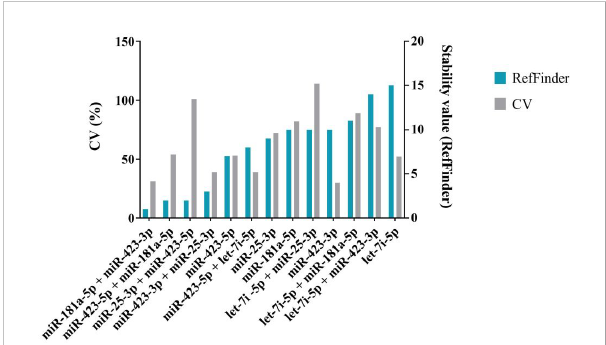
FIGURE 4 Analysis of a selection of endogenous controls and their combinations. The coef fi cient of variation (%) is shown in grey on the left y-axis. The stability values of the RefFinder algorithm, shown in blue, are plotted on the right y-axis. The lower the CV and the lower the stability value, the more stable the miRNA is and the more suitable it is for use as an endogenous control. The combination miR-181a-5 + miR-423-3p has the lowest stability value and CV value. It was selected as endogenous control.